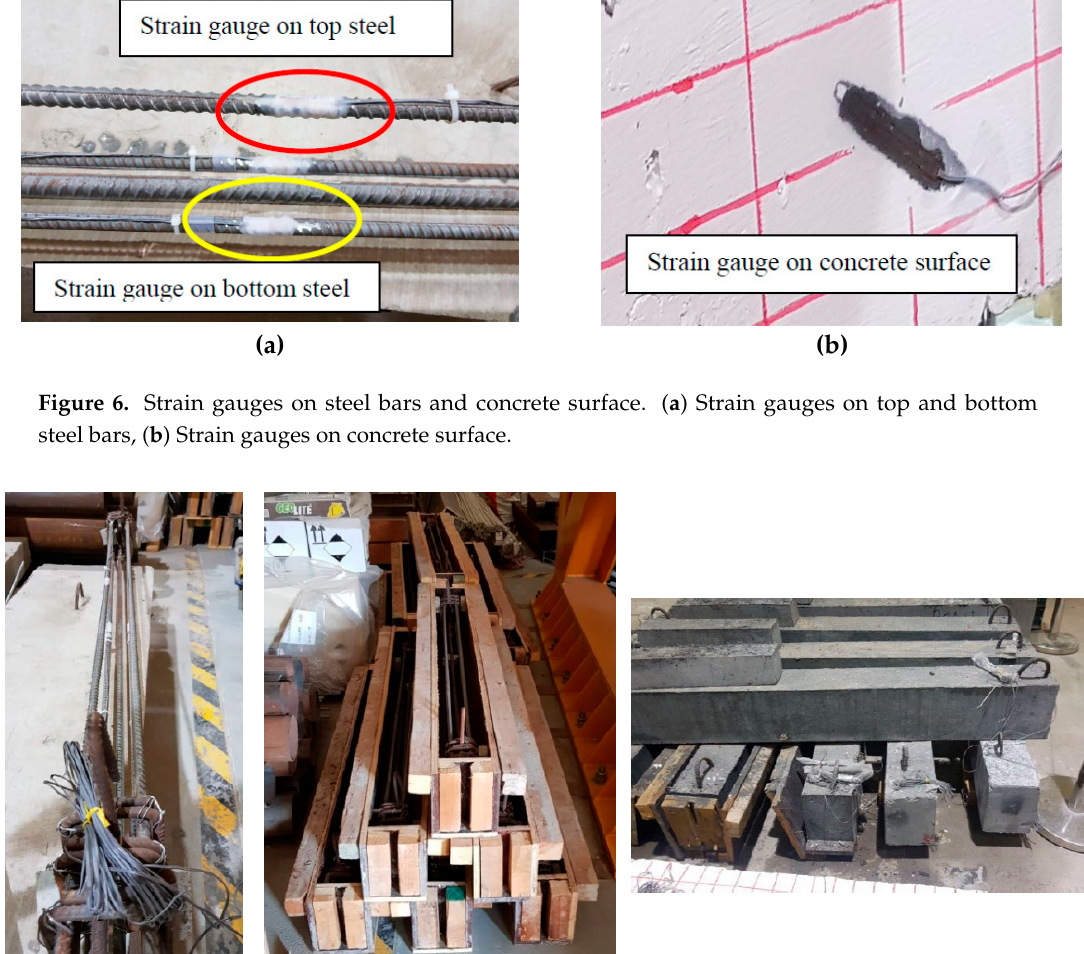
( b ) Figure 4. Samples preparation for mechanical properties. ( a ) Molds used for sample preparation, ( b ) Samples for mechanical evaluation. ( a ) ( b ) Figure 5. Beam and cross section details. ( a ) Elevation reinforcement and strain gauges location, ( b ) Beam cross-section. All dimension are in mm. Three strain gauges, Tokyo Measuring Instruments Laboratory, Tokyo, Japan, were placed on